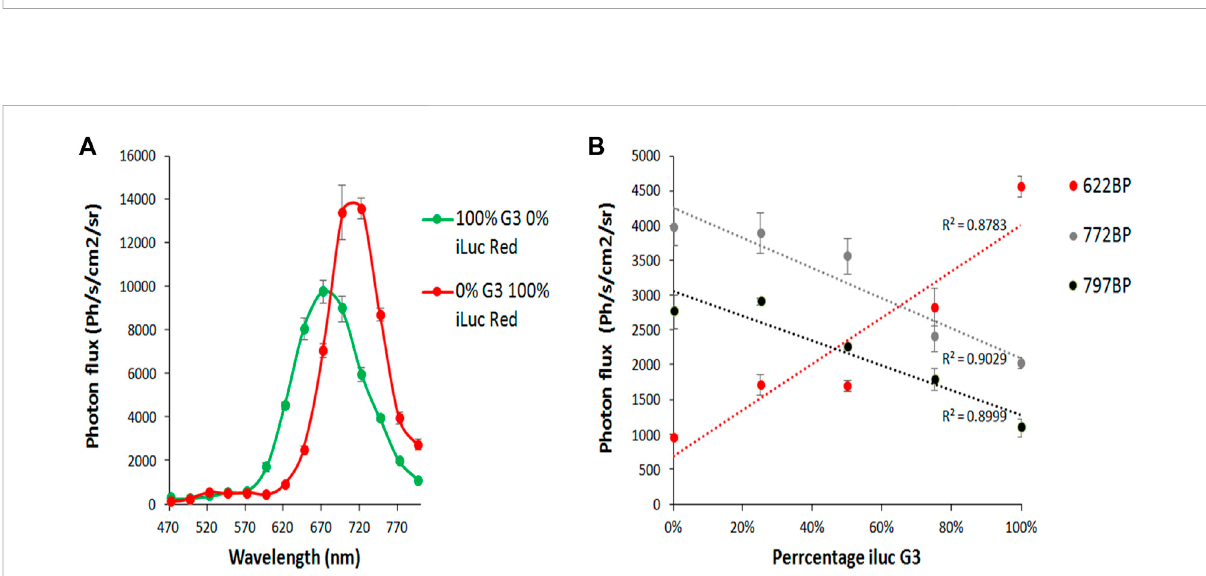
FIGURE 7 Imaging and unmixing HEK 293 cells expressing dual mixes of ilucG3 and ilucR. Substrates were dispensed with a multiwell pipette and, after 5 min, were imaged in successive fi lters on the PIO (622, 722, and 797 nm band-passes (BP)). Regions of interest were analyzed for photon fl ux at different wavelengths using the M3 Vision software. (A) Quantitative bioluminescence spectra from variants. (B) Increasing percentage of ilucG3 imaged through 622, 722 and 797BP fi lters.